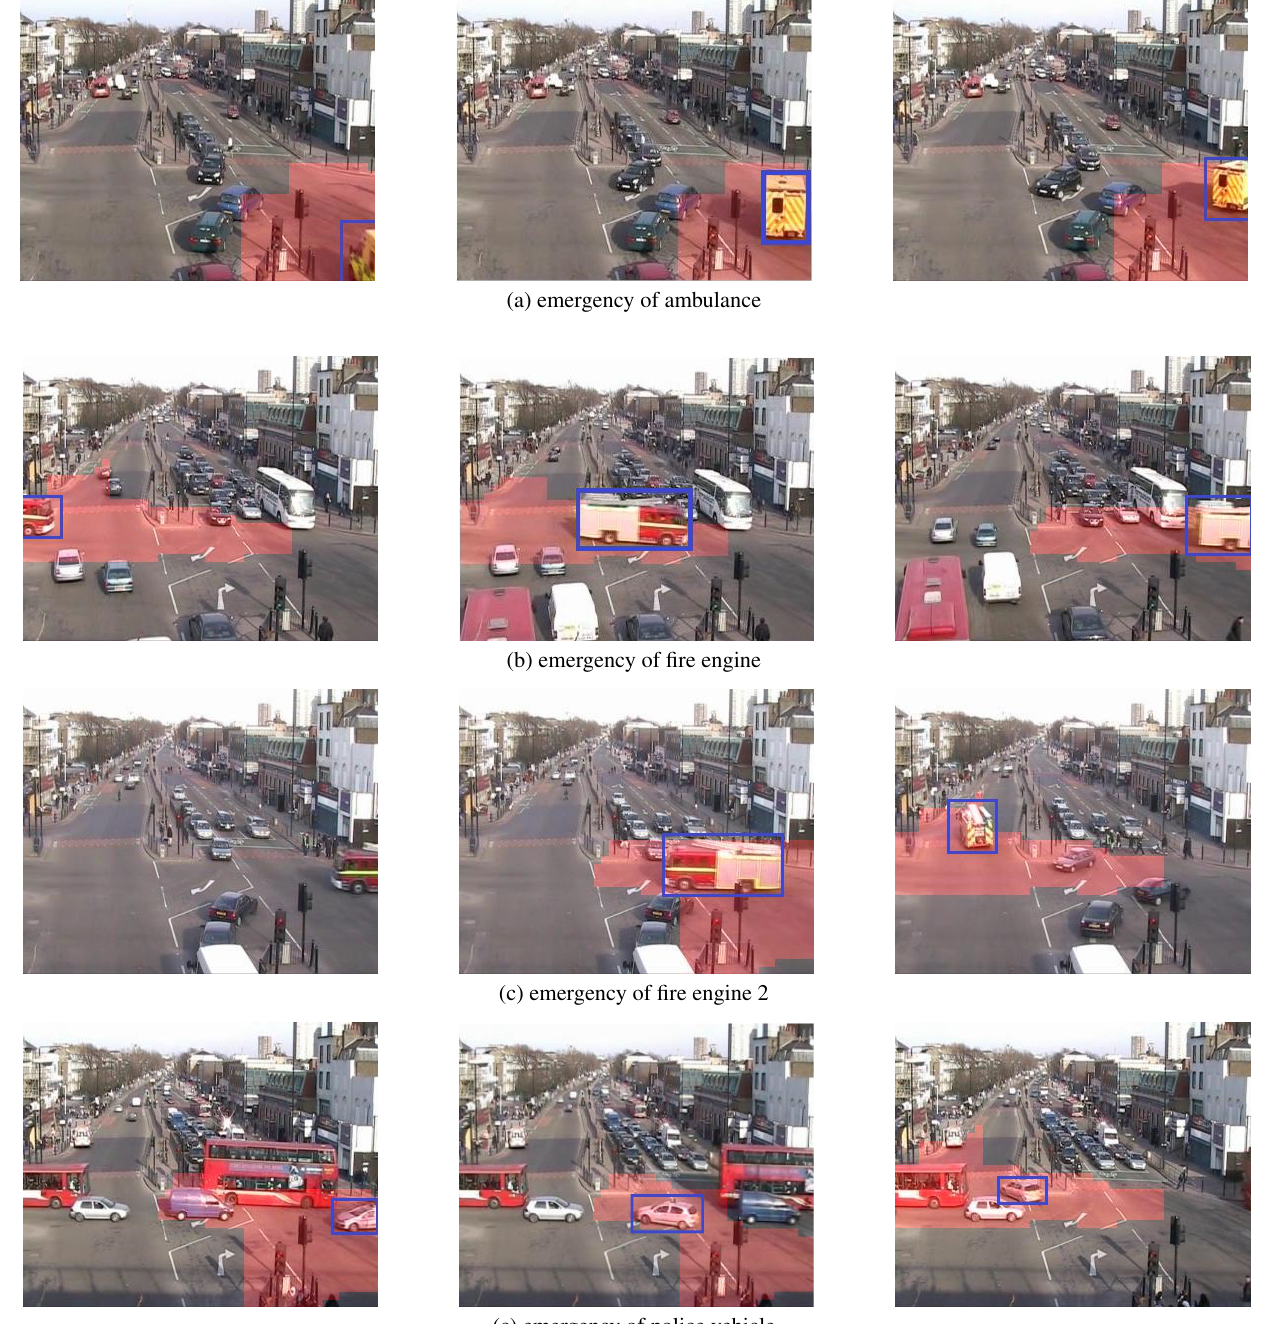
Figure 3: Examples of detected anomaly caused by emergency vehicles using our GP models (abnormal regions are denoted in red whilst the corresponding abnormal object is highlighted with a